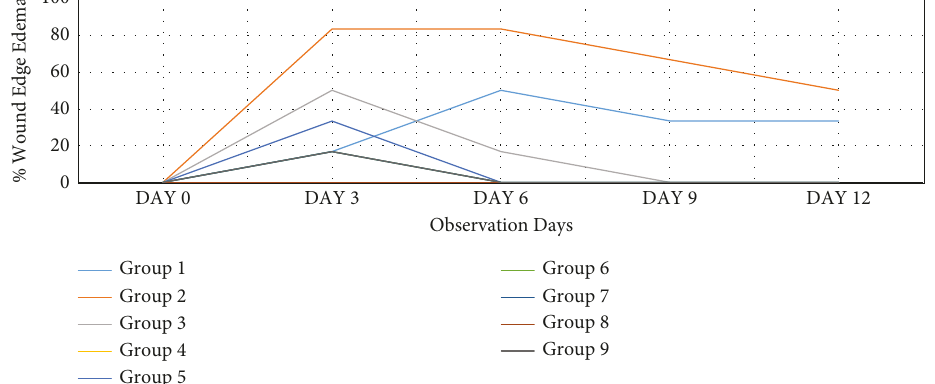
Figure 6: Wound edge oedema (%) in experimental groups on days 3, 6, 9, and 12 after wounding.